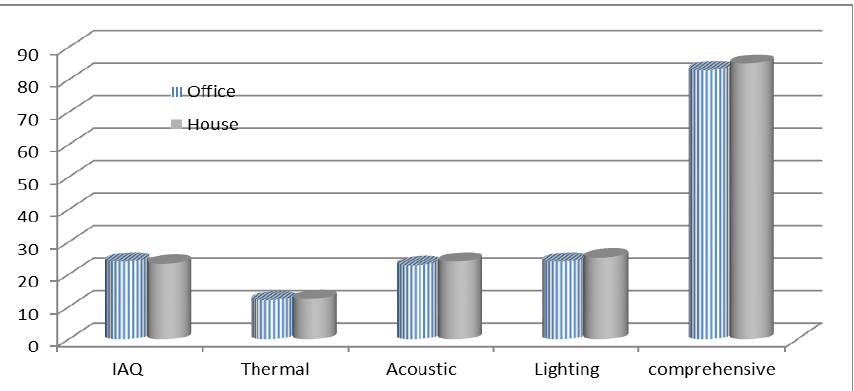
Figure 2. Indoor environmental index (IAQ, thermal, acoustic, lighting, and comprehensive index) evaluated score results.